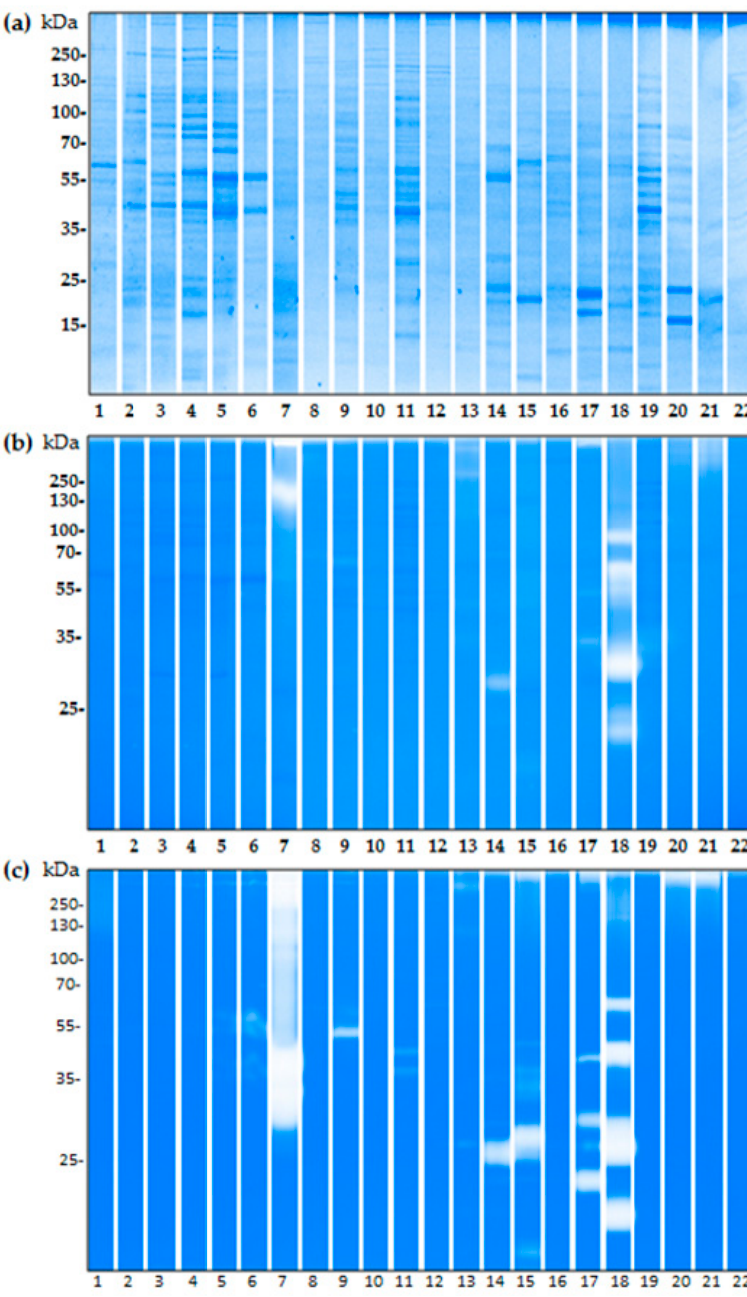
Figure 4. Gel electrophoresis was performed for ( a ) Coomassie stained SDS-PAGE gel and zymographic methods using ( b ) 0.1% casein ( c ) 0.1% gelatin for birch pollen derived bacterial isolates described by bacterial family in Table 2, numbered 1–22. (Gram negative: 1–7; Gram-positive: 8–22). Within the casein gel (Figure 4b) the gram positive bacterial strains numbered 9, 13, 14, 15, 17,